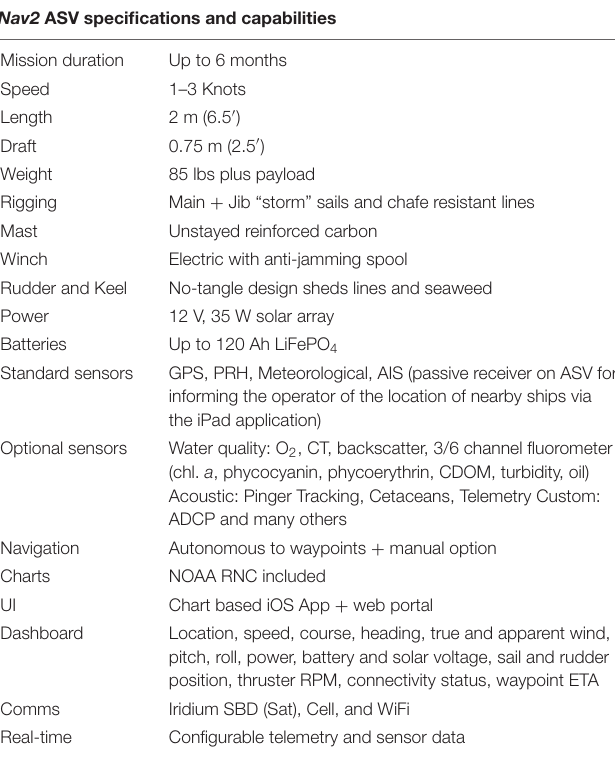
TABLE 1 | Specifications for the Nav2 Autonomous Sail Vehicle